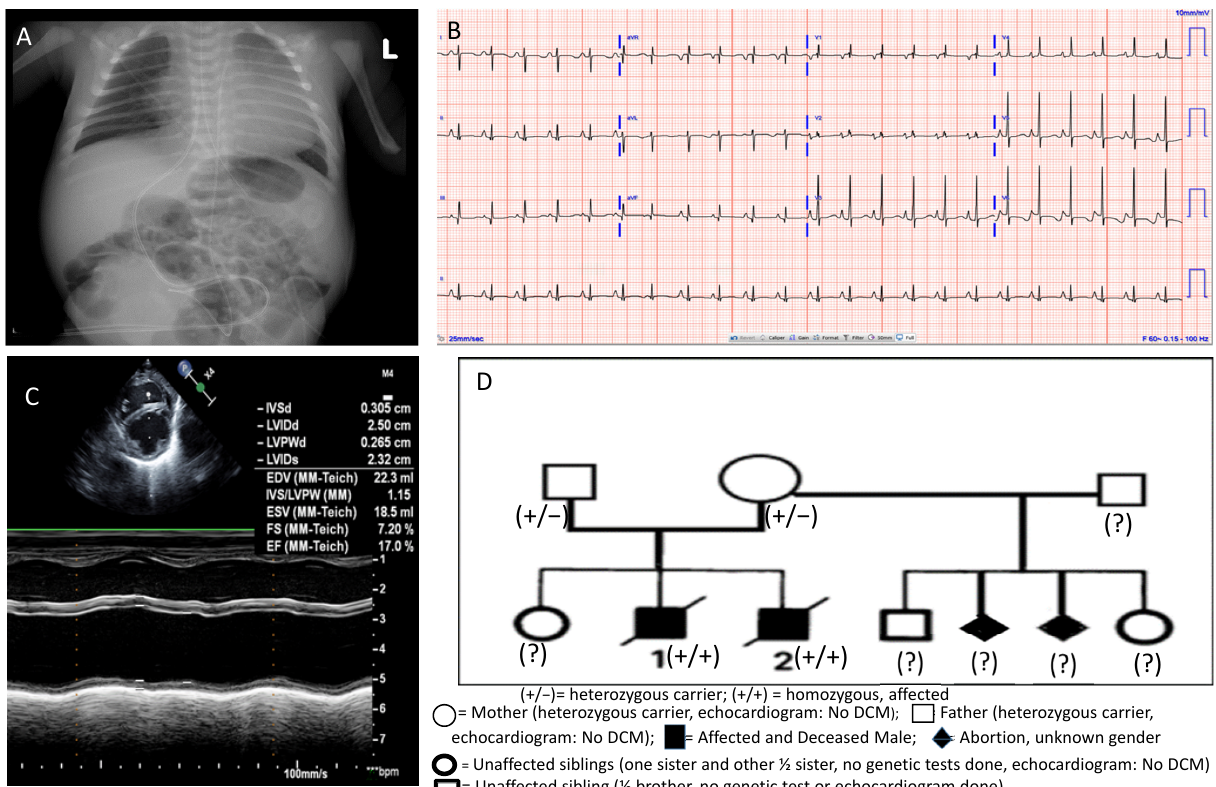
Figure 1. ( A ) Chest X-ray showing severe cardiomegaly on day 1 of life; ( B ) electrocardiogram showing nonspecific ST changes and biatrial enlargement; ( C ) M-mode echocardiography displaying left ventricular dilation and severely depressed function; ( D ) family pedigree showing RPL3L variant identification in family